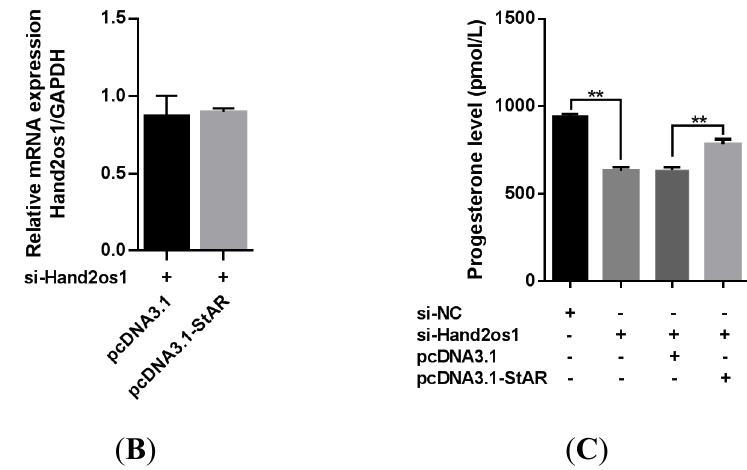
Figure 7. Effects of StAR overexpression on the progesterone production inhibited by si- Hand2os1 in LCs. qRT − PCR analyses of ( A ) StAR and ( B ) Hand2os1 mRNA levels 24 h after transfection with si- Hand2os1 and pcDNA3.1- StAR . ( C ) The concentration of progesterone in the culture supernatants were determined by ELISA. GAPDH was used as the reference gene for normalization. The data represent the mean ± SEM from three independent experiments. ** p < 0.01 compared with si − NC group, and different number of asterisks on bars indicate statistically significant differences ( p < 0.05).